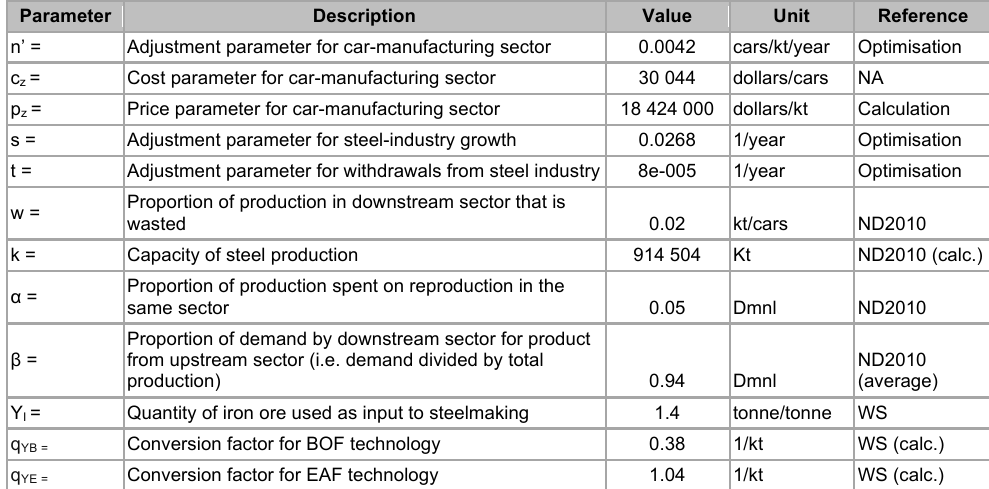
List of exogenous parameter values in the